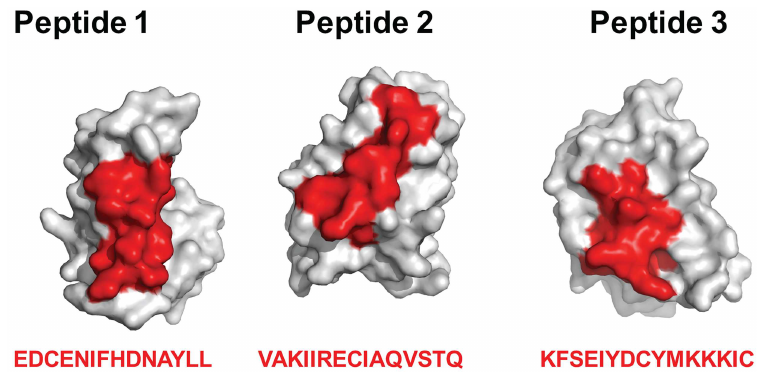
Fig 4. The three predicted T cell epitopes on SALO are located on exposed helices. The position of peptidesequencesgiven at the bottom is shown in red on the SALO structural surface